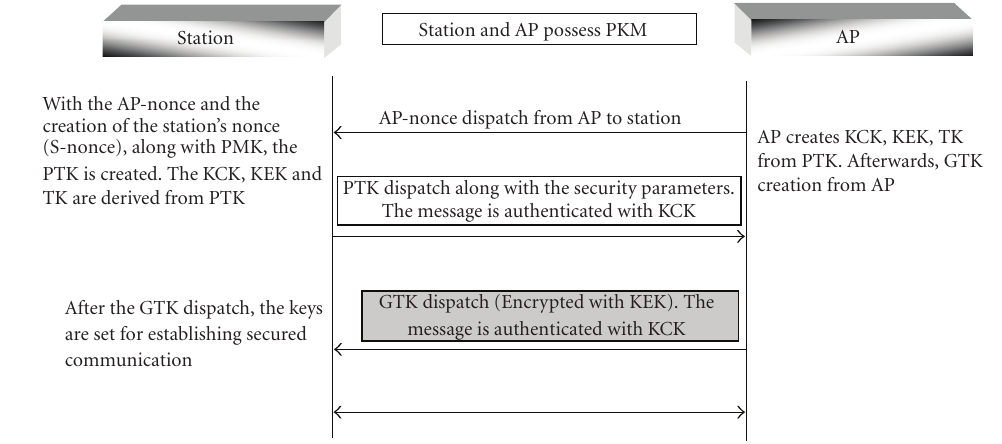
Figure 6: EAPOL key material